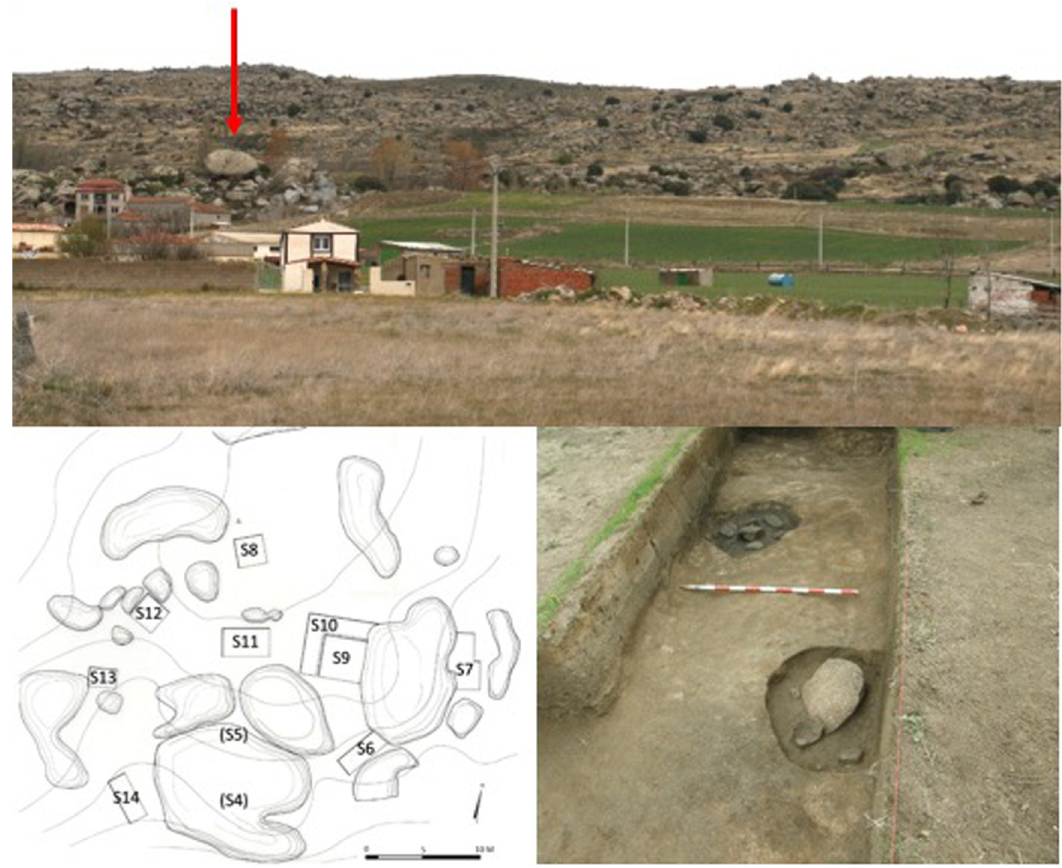
Figure 4: Above, view of La Atalaya, Muñopepe, from the south; below left, plan of the excavation testing trenches; below right, two of the Copper Age pits during their